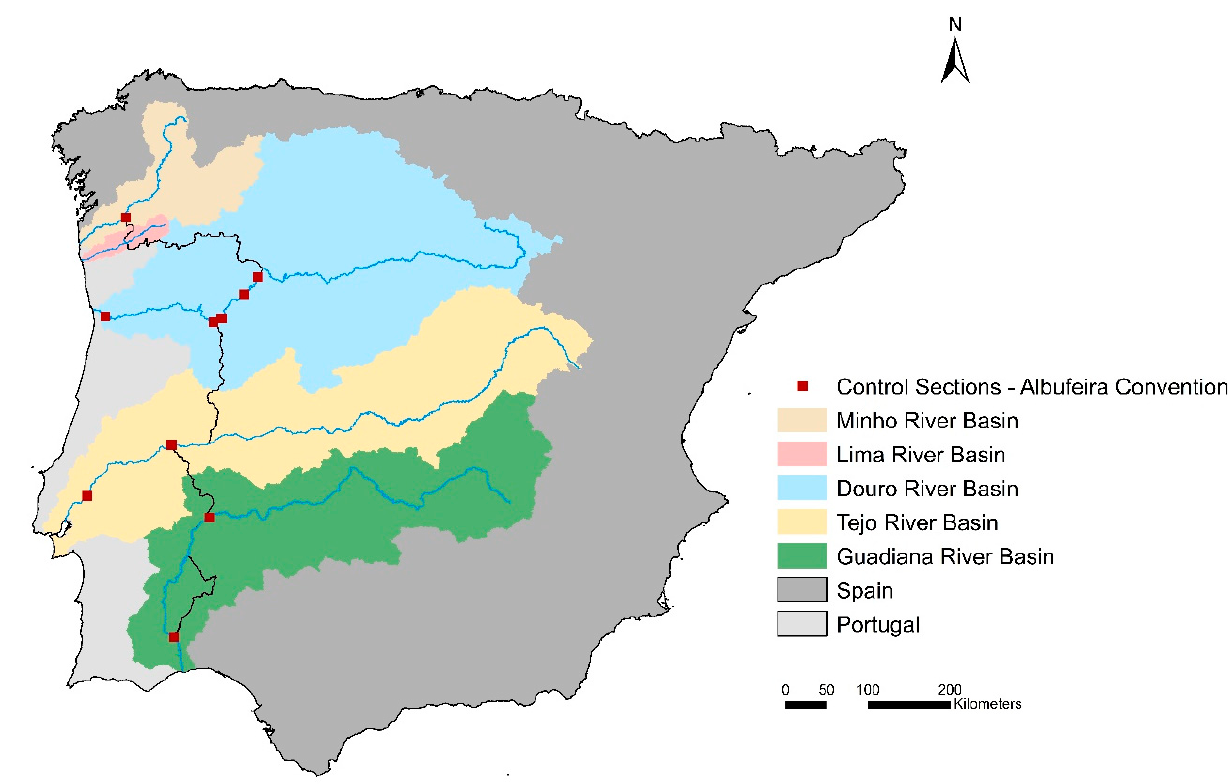
Figure 1. Transboundary river basins in the Iberian Peninsula and respective flow control sections under the Albufeira Convention.